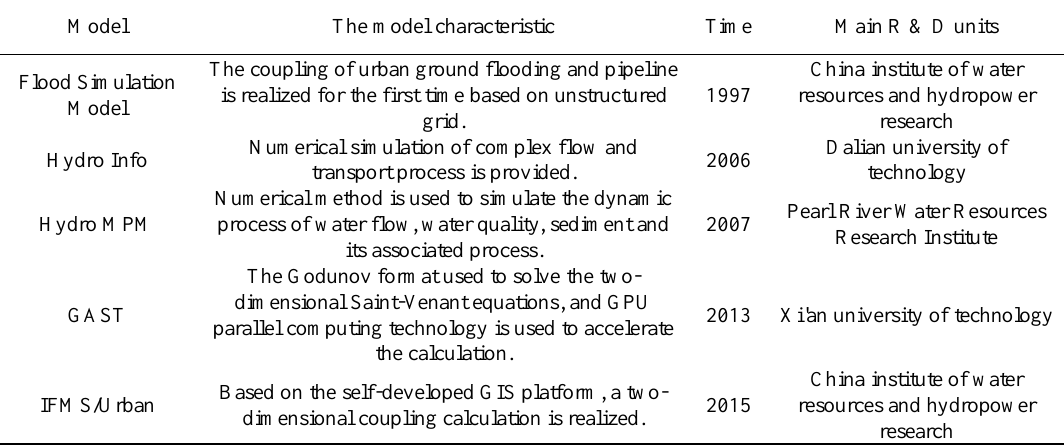
Table 1 Flood model of main cities in